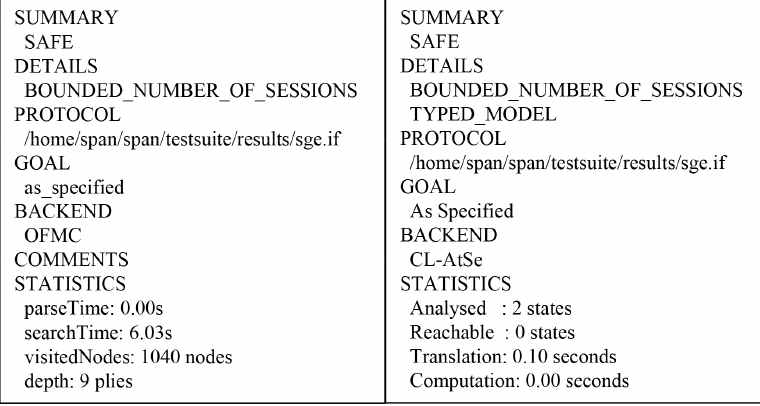
Figure 13. AVISPA simulation result using OFMC and